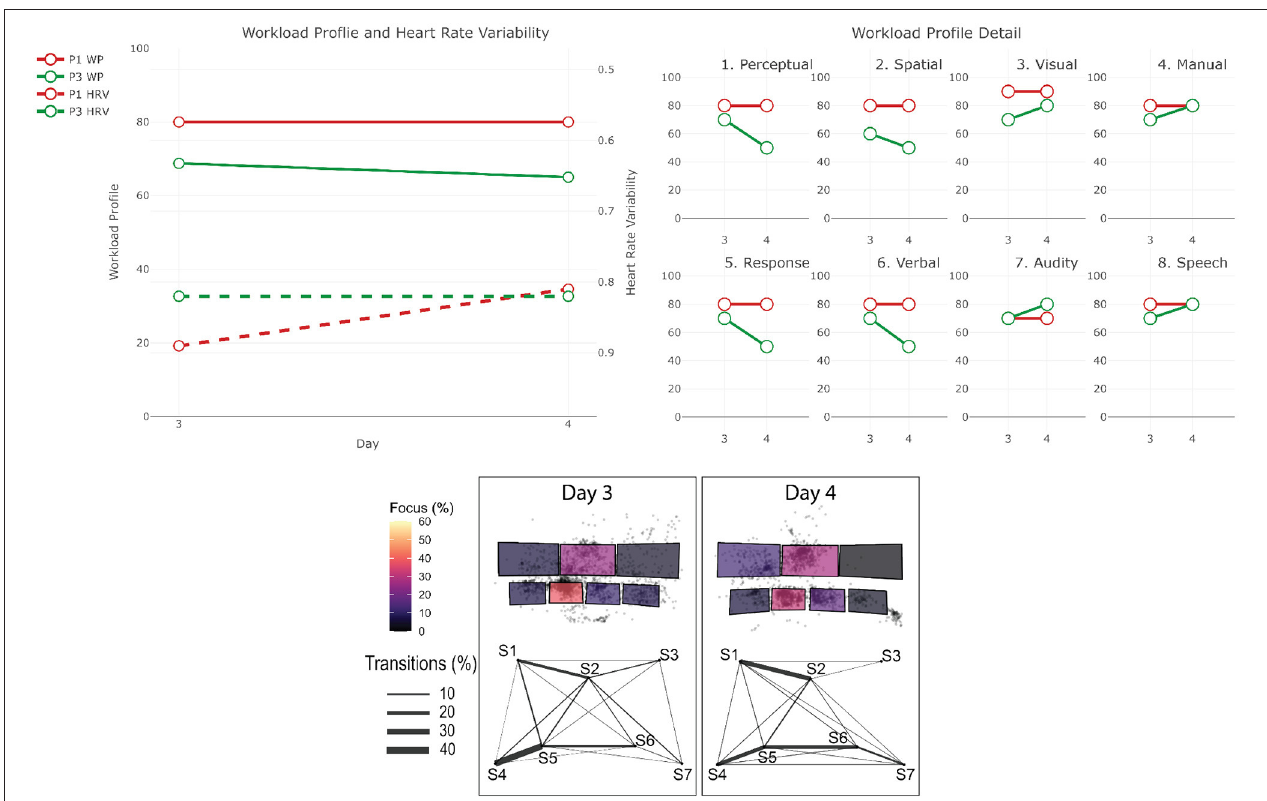
FIGURE 9 | Results for the two normal operation sessions. The top-left chart shows the evolution of the WP and HRV during the session for both participants (the axis of the HRV is inverted). The top-right chart shows the evolution of each criteria of the WP during the session for both participants. The bottom chart displays eye tracking data for P3 for each phase: at the top is the schematic representation of the operator’s workspace with a heatmap showing the amount of time the operator spent focusing on each screen; the bottom graph indicates the amount of transition between each of the screens with the thickness of the lines. The same organization is used in the following